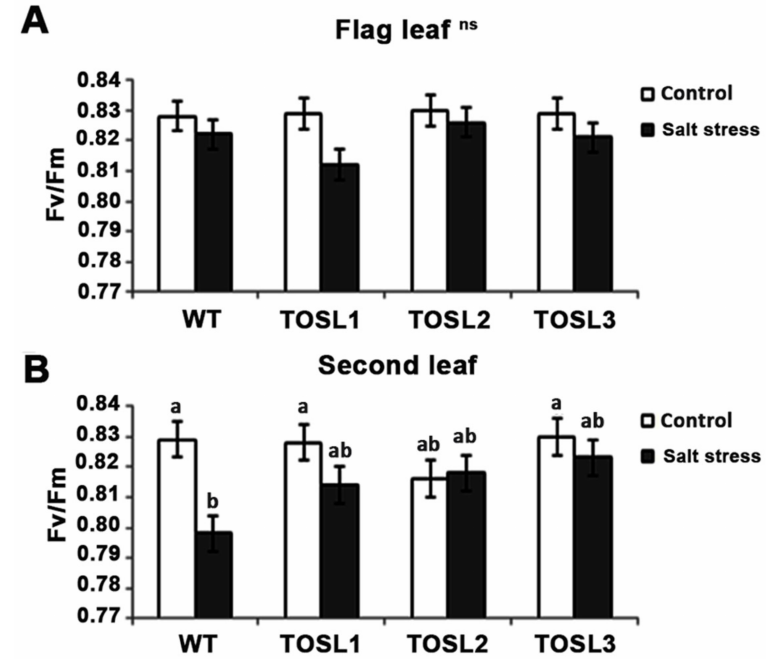
Figure 5. The F v /F m ratios of flag leaves ( A ) and second leaves ( B ) under control conditions and after being treated with 150 mM NaCl solution for 9 days. Three independent OsNUC1-S transgenic rice lines with difference transgene expression levels and WT plants were used. The data were presented as the mean ± SE and a different letter above the bar showed the significant difference in means ( p < 0.05) based on Tukey’s range test analysis. ns represents no statistically difference among